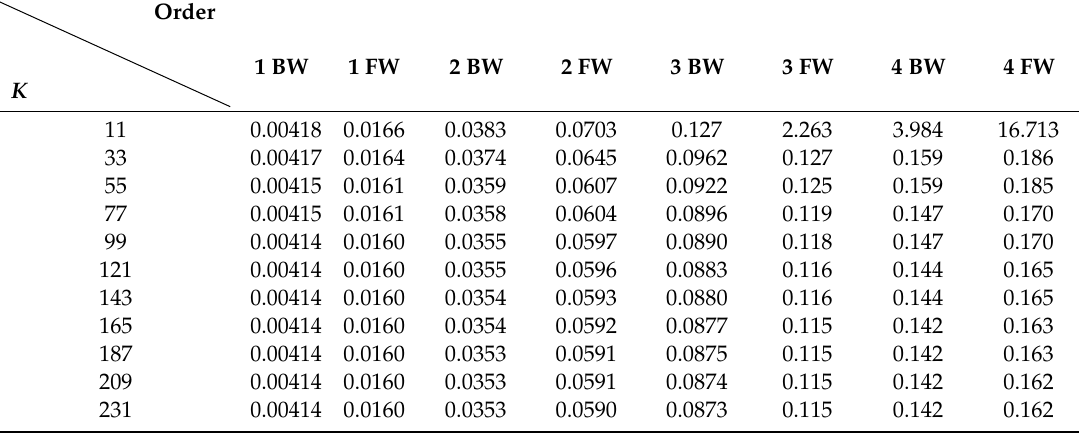
Table 7. Natural frequencies via modal discretization ( h = 1000